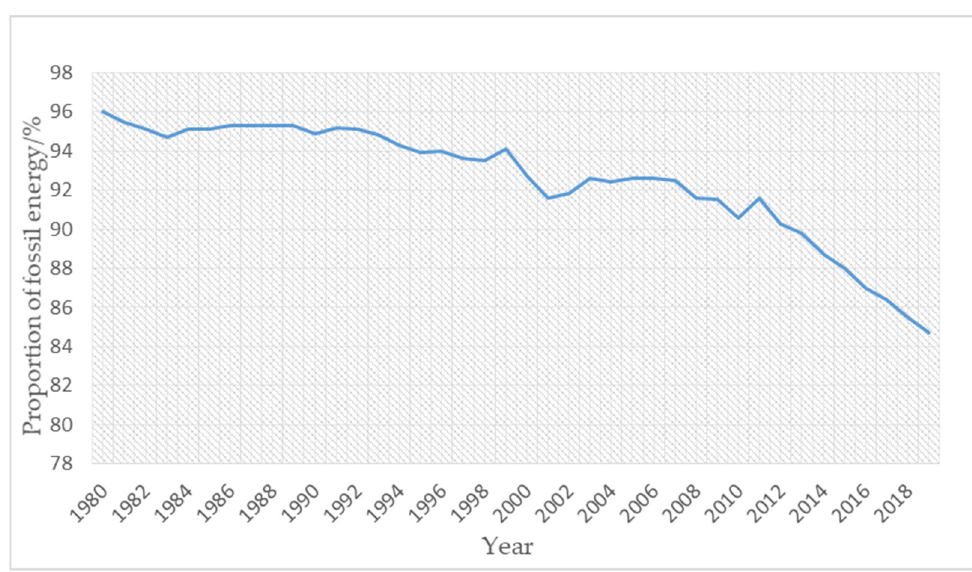
Figure 2. Trend chart of fossil energy consumption in China.